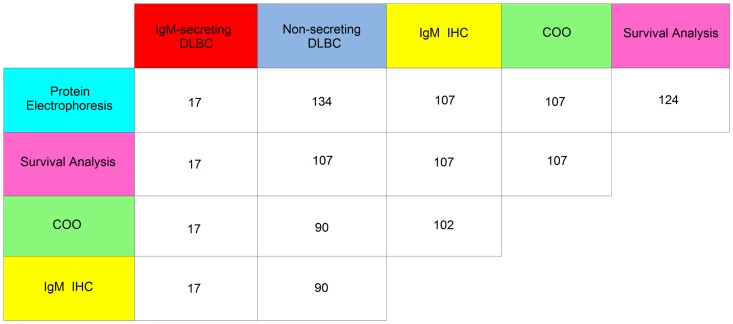
The cross table diagram shows in the colored rectangles the type of analysis that was carried out or the subgroup of DLBCL (non-secreting and IgM-secreting).The white rectangles show the number of cases that match the crossing of horizontal and vertical rows.